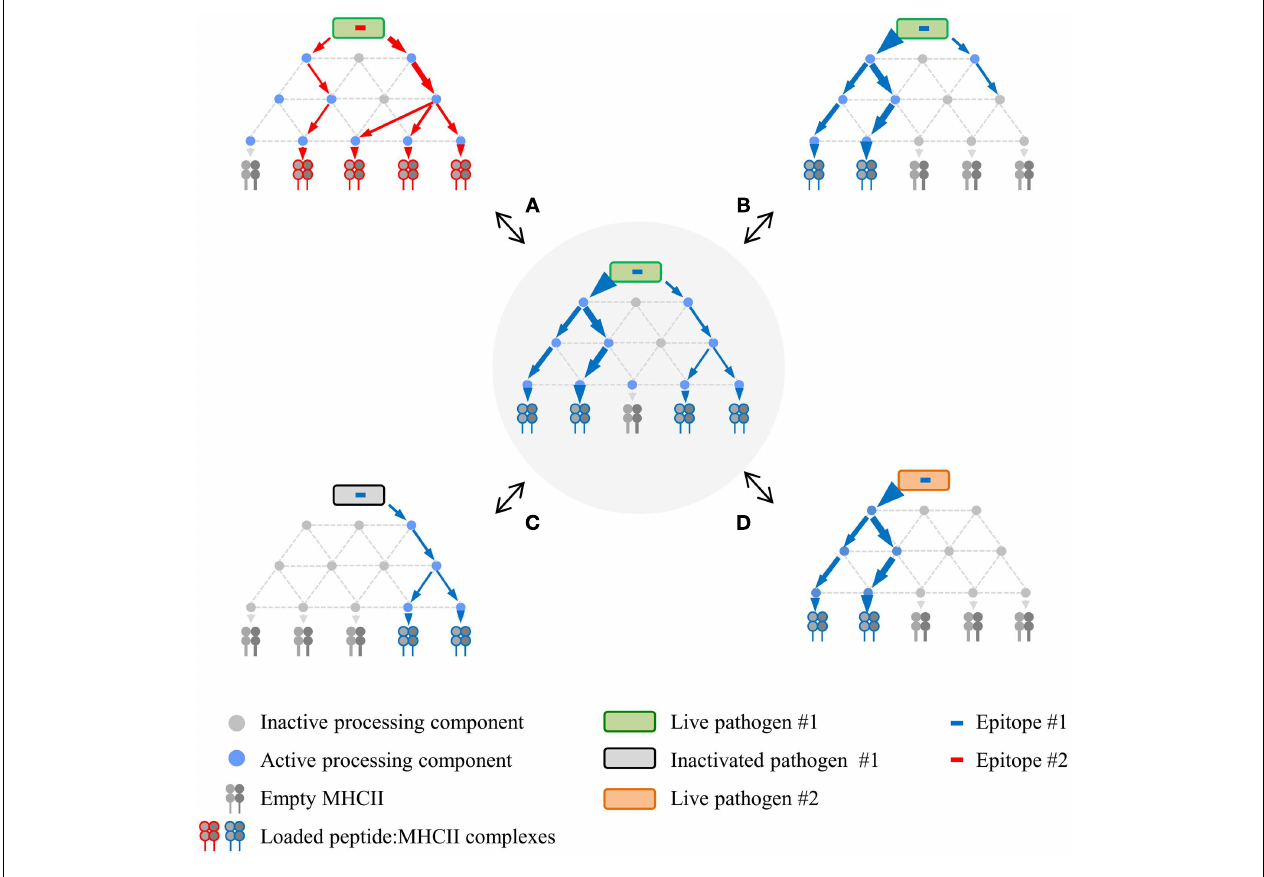
live pathogen (A) , different APC for the same epitope (B) , same epitope from inactivated pathogen (C) , or same epitope expressed via recombination by a different live pathogen (D) . Processing components can be either active or inactive depending on APC type and/or APC activation state in response to